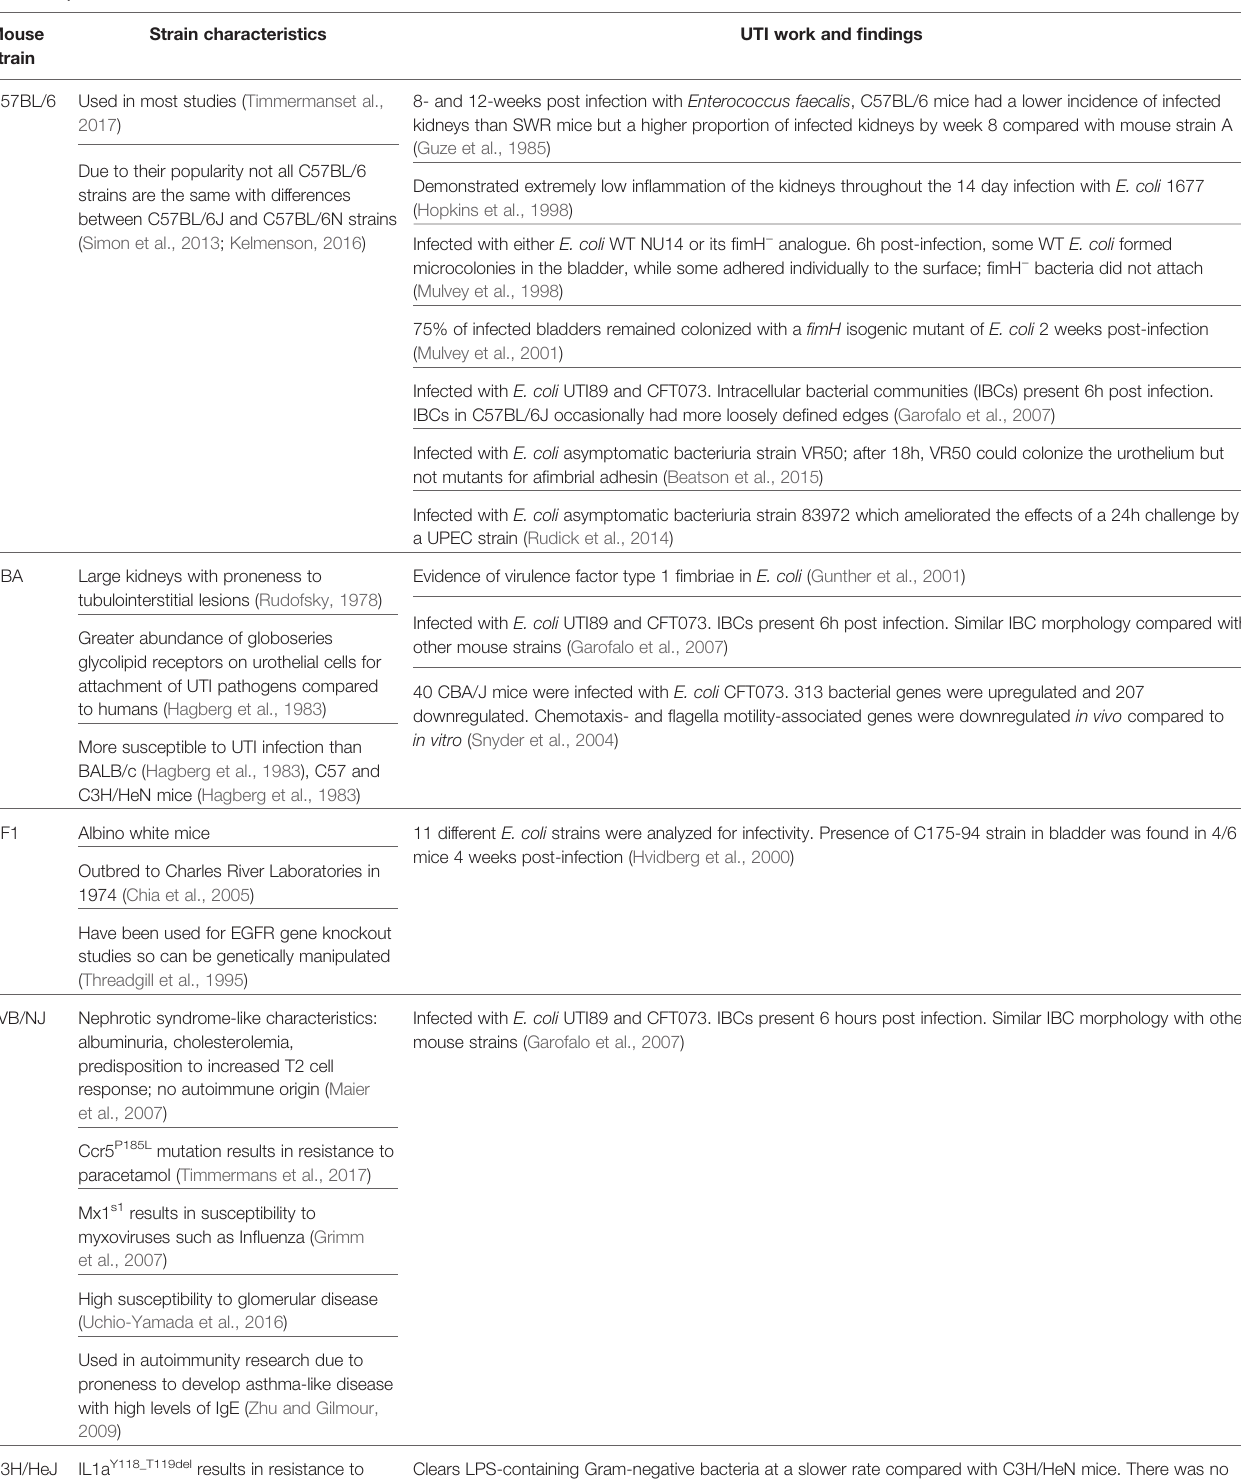
TABLE 1 | Mouse models used for UTI research. Mouse